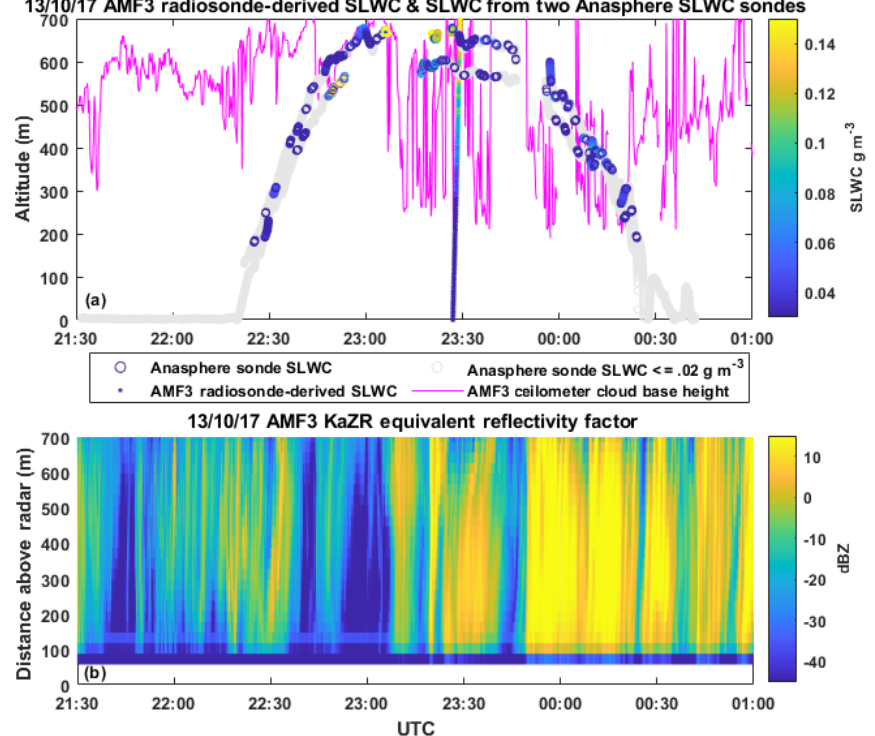
Figure 7. TBS flight of two SLWC sondes with concurrent free-balloon radiosonde launch on 13 October 2017 at 23:27UTC. In (a) the RAOB LWC values calculated from the 23:37UTC AMF3 free-radiosonde launch are plotted (dots), as well as SLWC measured by two TBS SLWC sondes (circles), the lowest cloud base height reported by the AMF3 ceilometer (magenta), and the reflectivity from the AMF3 KaZR (b)